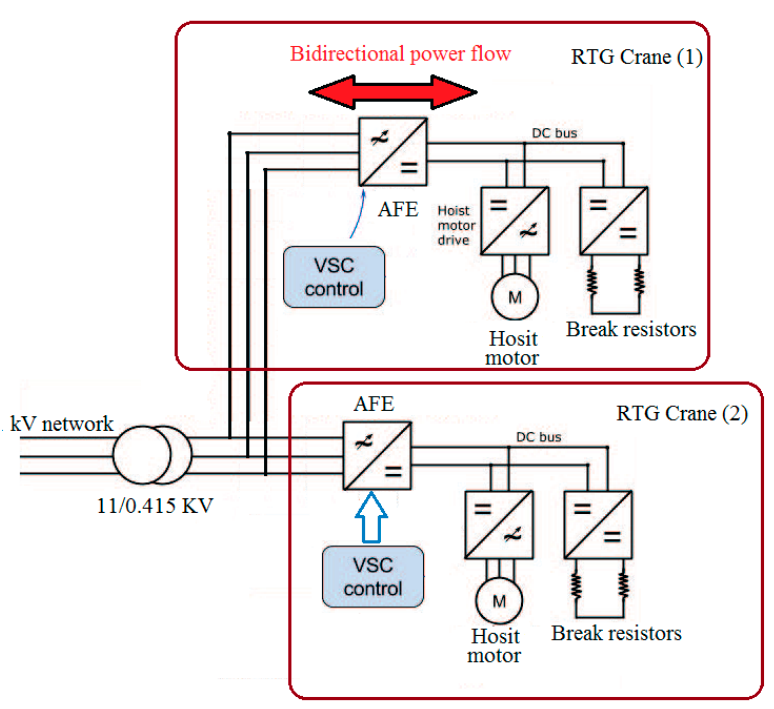
Figure 6. Block diagram of the AFE system.